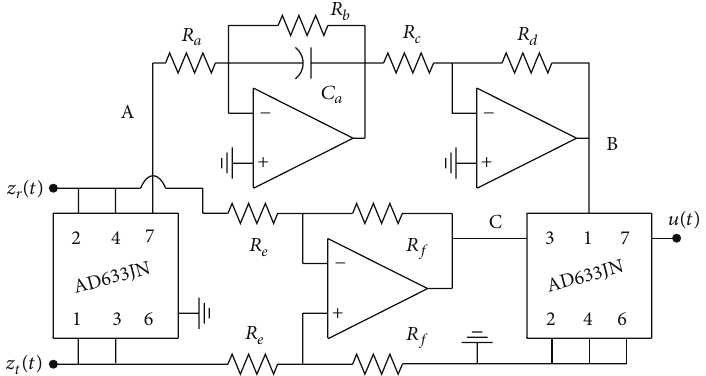
Figure 2: Synthesis of (11) with Op Amps and analog multipliers.